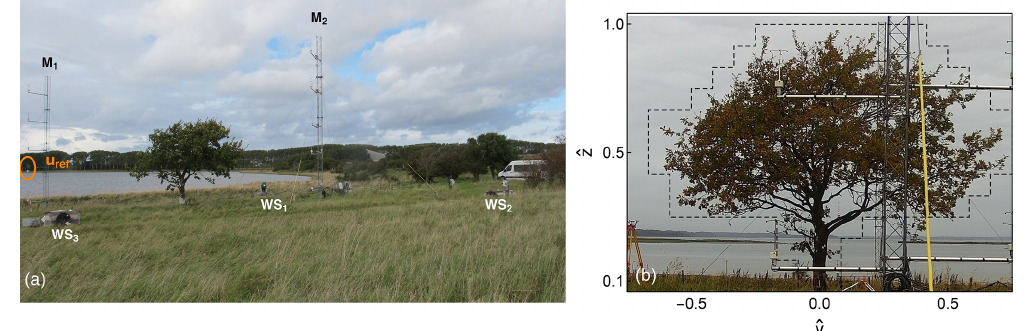
Figure 1. Photographs of experimental set-up. (a) Area surrounding the oak tree, where the three scanning wind lidars (WS 1 , WS 2 and WS 3 ) and the two meteorological masts (M 1 and M 2 ) were located. (b) A view from the lee side of the frontal area of the tree. The y and z axes are normalized by the tree height.